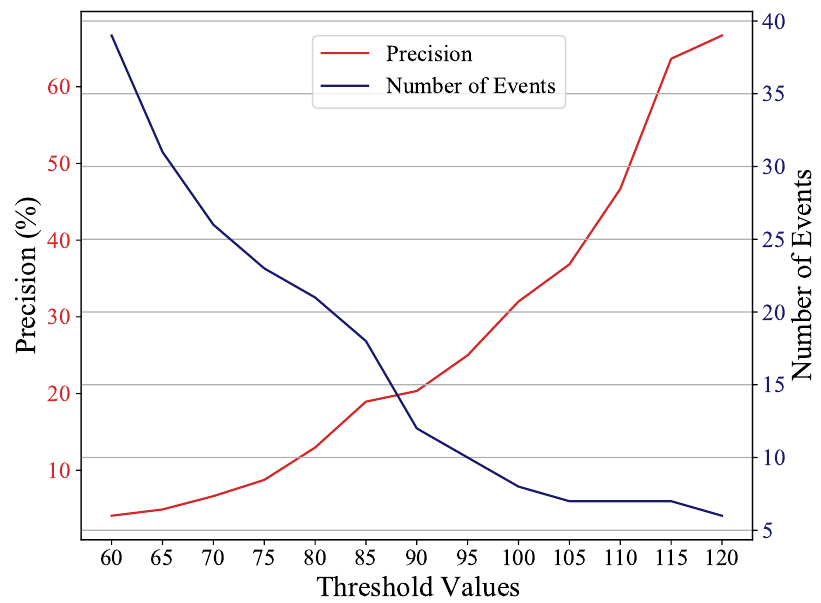
Figure 11. Precision of STA/LTA along with the number of the detected events at each threshold value. Using a higher threshold value increases the precision but at the expense of reducing the number of detected true events. Even with the highest threshold value, the STA/LTA precision (67%) remains less than the CNN precision (88.9%), and it picks only 6 events for this case compared to 40 events picked by the CNN